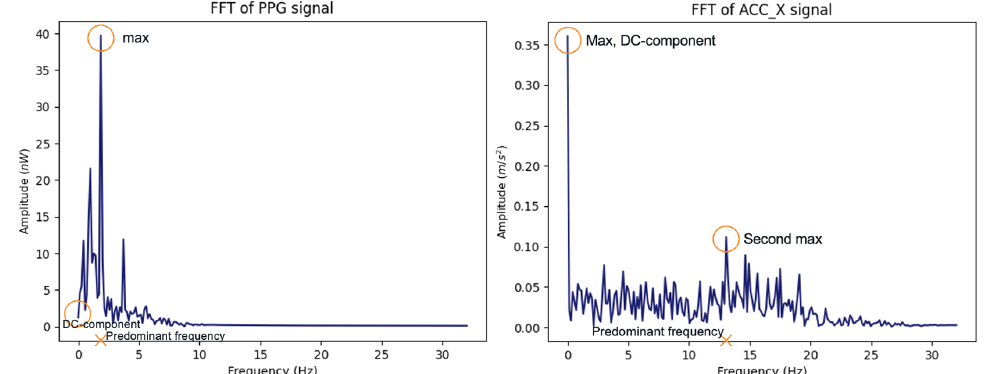
Figure 4. A seven-second window of PPG and X-axis of ACC signals transformed to frequency domain related to the “cycling” activity. Notice the difference between DC components, moreover, maximum amplitude and its corresponding frequency (predominant frequency) for different sources of